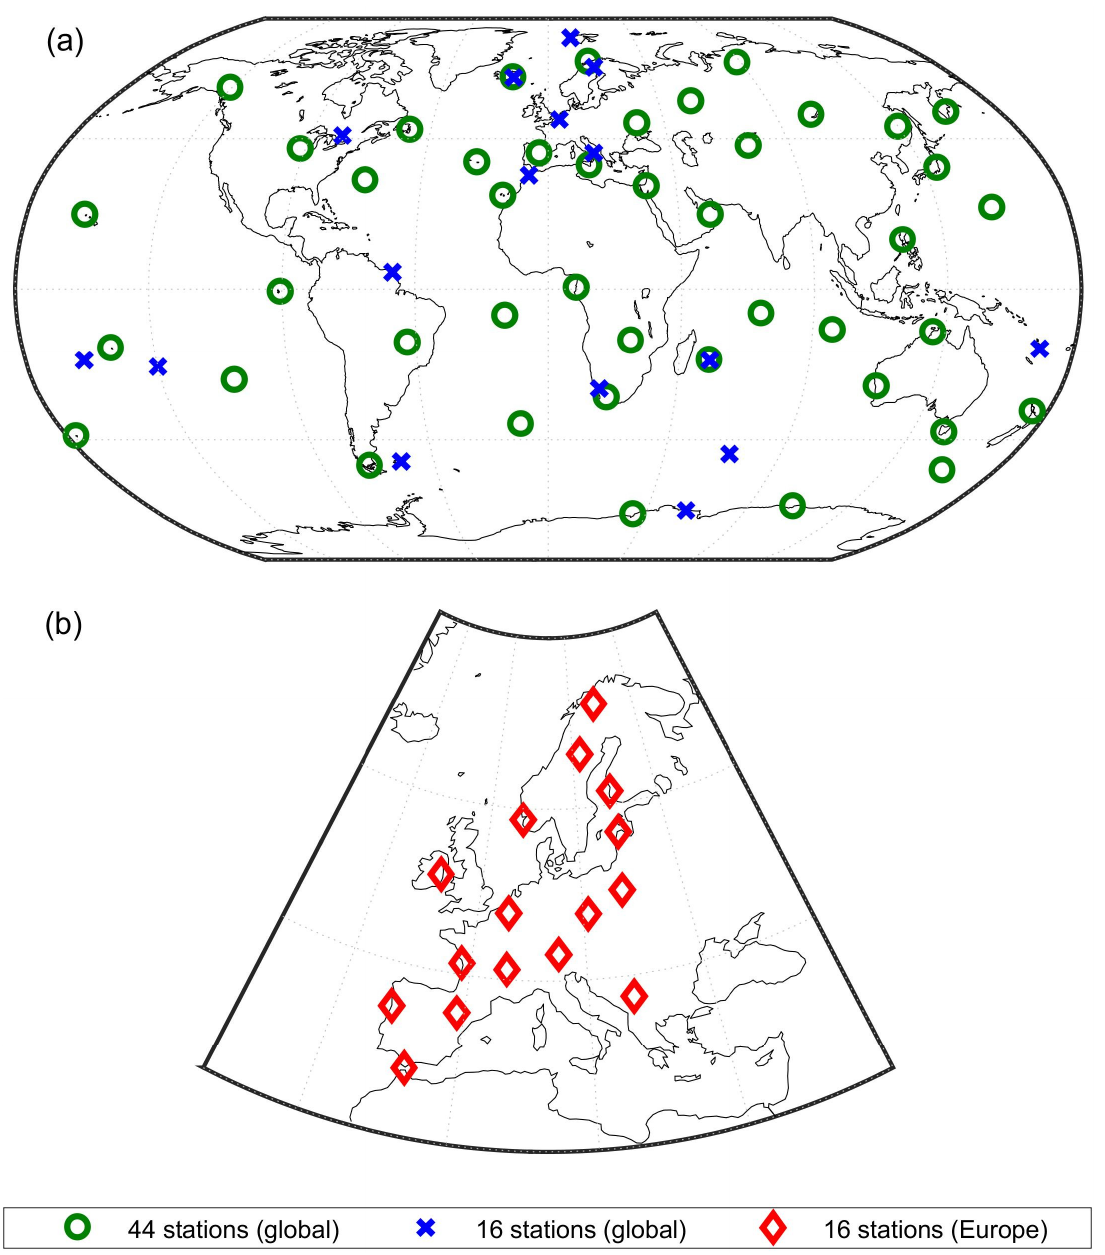
Figure 2. Location of the GNSS ground stations used in the simulations, shown on the two maps for better readability: ( a ) 44 and 16 stations placed globally, and ( b ) 16 stations in Europe.